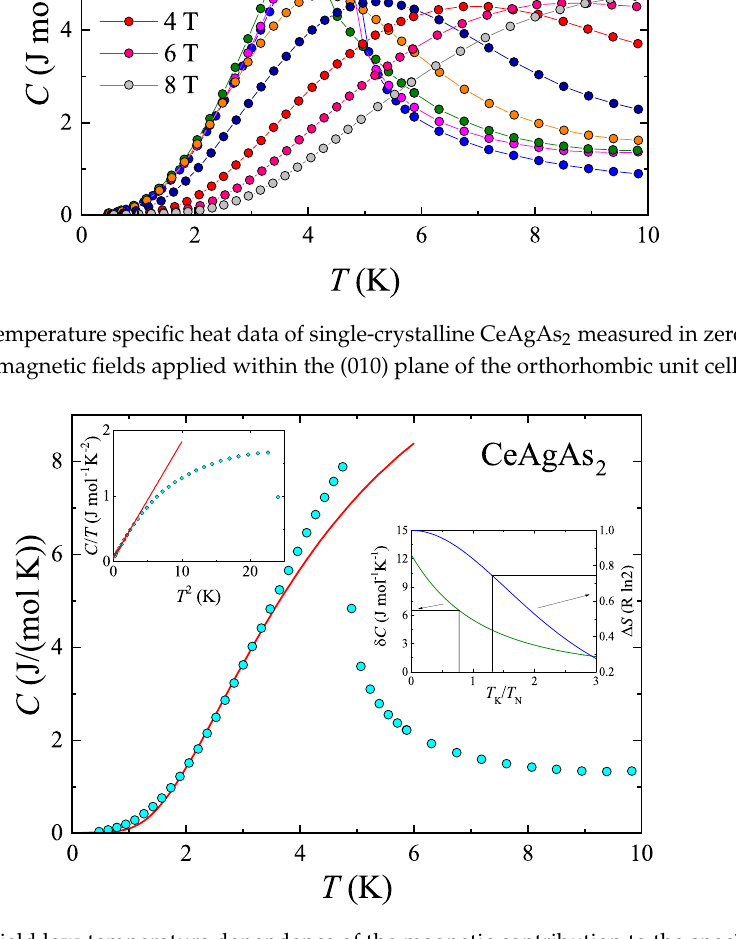
Figure 5. Zero-field low-temperature dependence of the magnetic contribution to the specific heat of CeAgAs 2 . Solid line represents the function described in the text. The left-hand side inset presents the C / TvsT 2 dependence. The right-hand side inset visualizes the methods used to estimate the Kondo temperature (see the